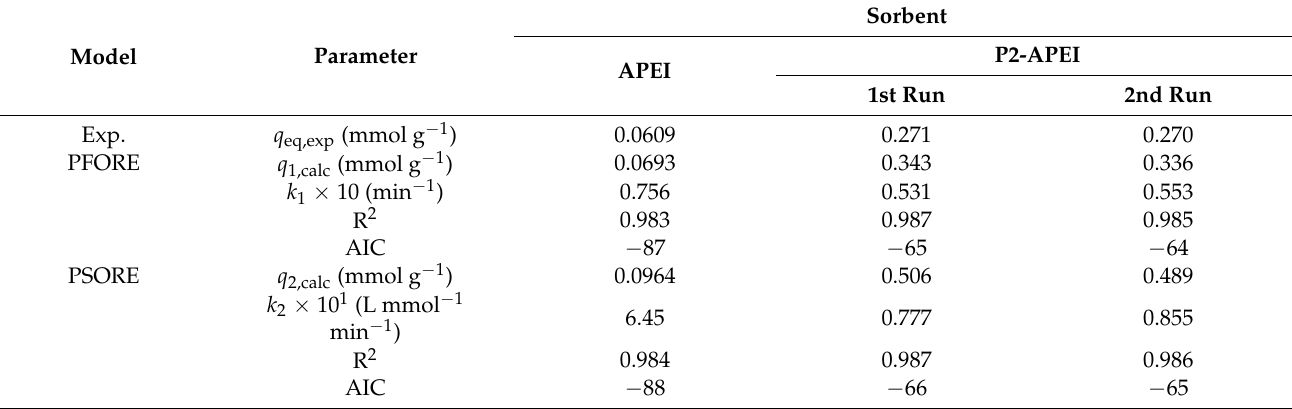
Table 7. Tm(III) desorption kinetics using the APEI and P2-APEI sorbents—fitting parameters for the PFORE and PSORE